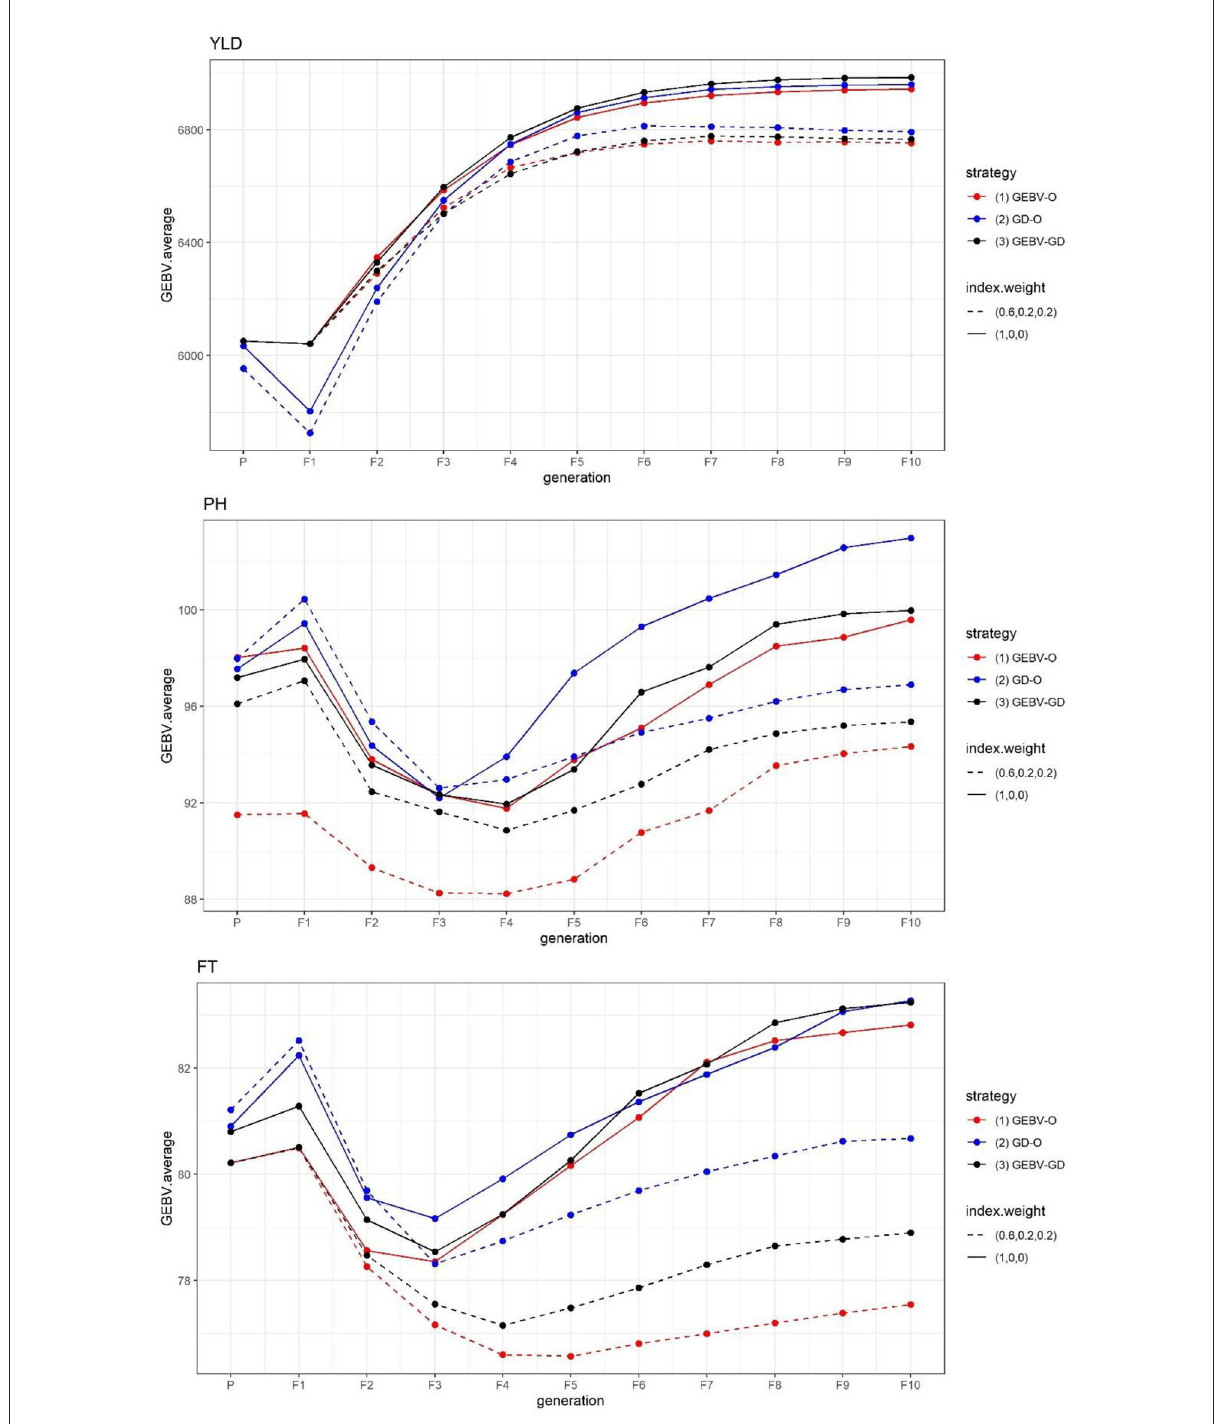
FIGURE1 GEBV averages of the best individuals at each generation for the tropical rice dataset. GEBV-O, Subset of the 10 accessions with the highest selection index values; GD-O, Subset of the 10 accessions with the maximal D -scores chosen from the candidate set S c ; GEBV-GD, Subset of the top two accessions with the highest selection index values, and another eight accessions chosen from the reminder of S c . YLD, grain yield; PH, plant height; FT, flowering